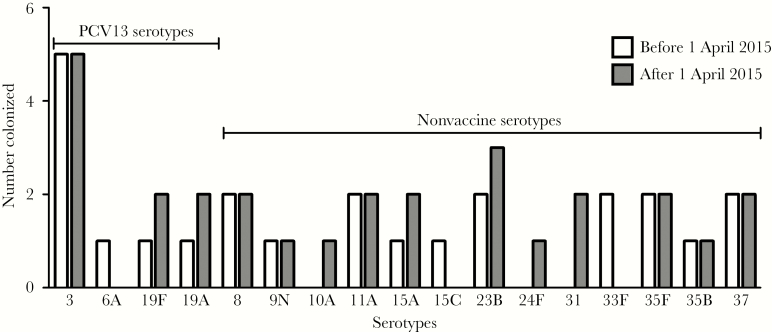
Serotype distribution among subjects colonized with vaccine serotypes (left) or nonvaccine serotypes (right) before (white bars) and after (gray bars) the 5-year anniversary of the introduction of the 13-valent pneumococcal vaccine (PCV13) in the United Kingdom.